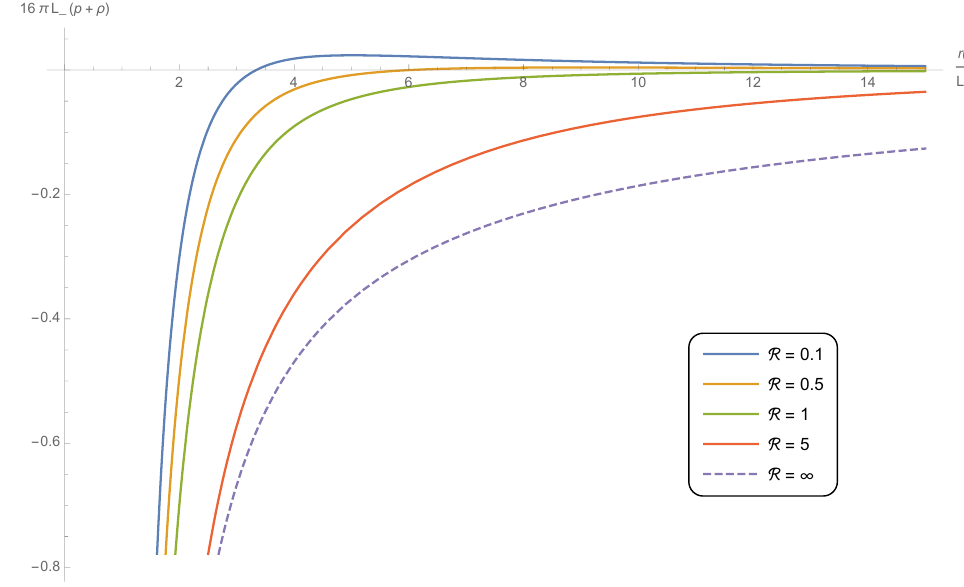
Figure 8 . Above is a plot of the sum of the energy density and pressure (i.e. ρ + p ) of the screen as a function of its radial placement for the case when d = 3 and r H /L − = 1 . Each solid line is a plot of the energy density of the screen in units of the interior AdS radius, L − , for different choices of the ratio R = L + /L − . For each line there is a divergence at r 0 /L − = 1 where the horizon of the black hole is. All the lines in the graph will saturate to a value of zero at infinity, however the way by which this is achieved is different depending on the value of R . Lines with R < 1 (blue and yellow line) actually cross the x -axis and then decrease and saturate to zero. Lines with R ≥ 1 (green, red, and dotted lines) stay below the x -axis and saturate to zero at infinity. This is consistent